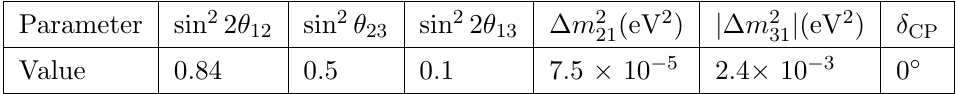
Table 2 . Benchmark values of the three-(cid:13)avor neutrino oscillation parameters considered in this